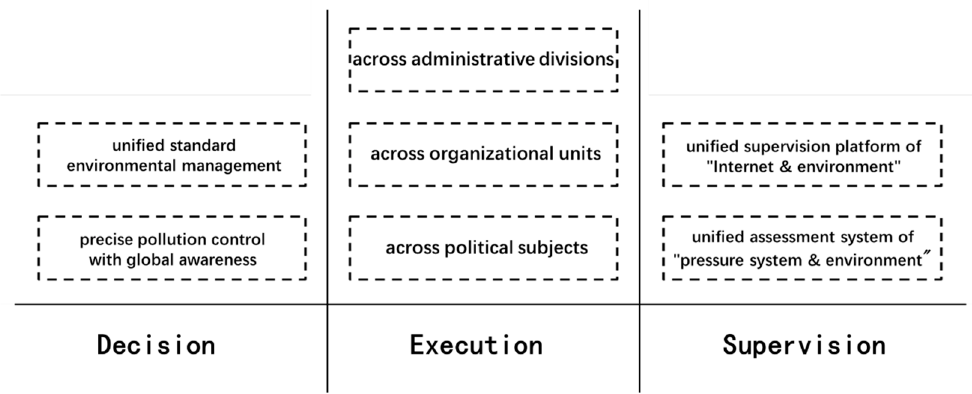
Figure 6. The path for improving collaborative environmental governance in the Yangtze River Delta.